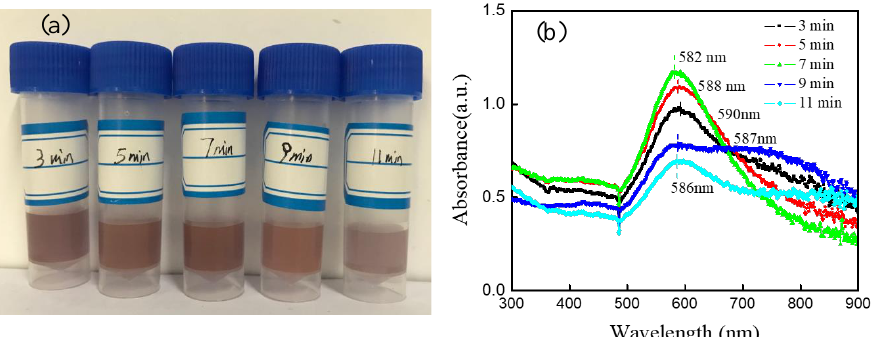
Figure 7. ( a ) Photos and ( b ) UV–Vis absorption spectra of AuNP for process times of 3, 5, 7, 9, and 11 min under P-Jet treatment (pulse frequency: 8 kHz, voltage: 8 kV, HAuCl 4 / sodium citrate ratio of 1:3).